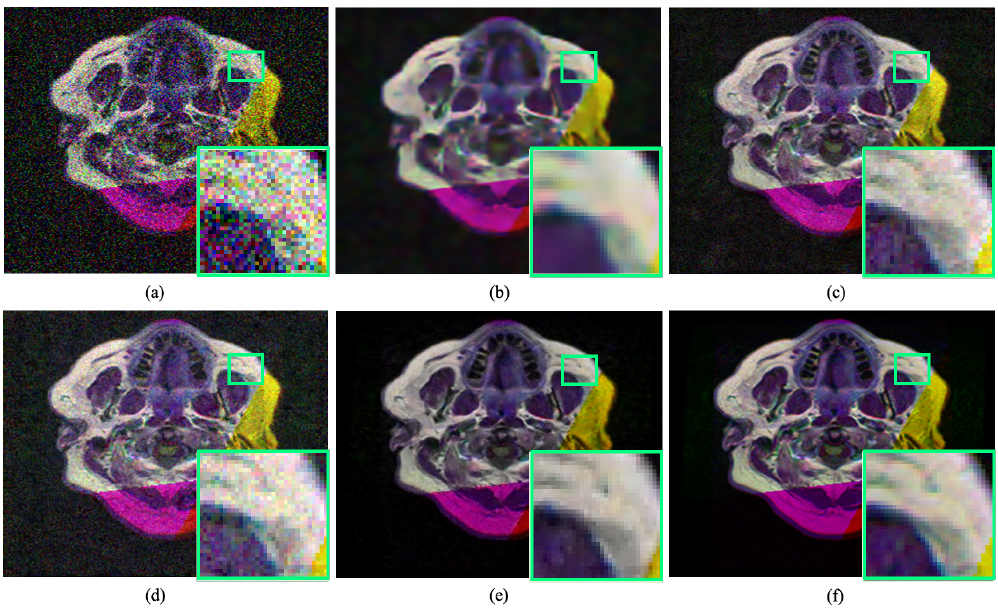
Figure 5. Qualitative comparison of radiology image denoising at σ = 50. The proposed method illustrates significant improvement over the existing denoising method by improving perceptual image quality. ( a ) Noisy input. ( b ) Result obtained by BM3D [11]. ( c ) Result obtained by DnCNN [16]. ( d ) Result obtained by Residual MID [12]. ( e ) Result obtained by DRAN (proposed). ( f ) Reference sharp image. Source by: